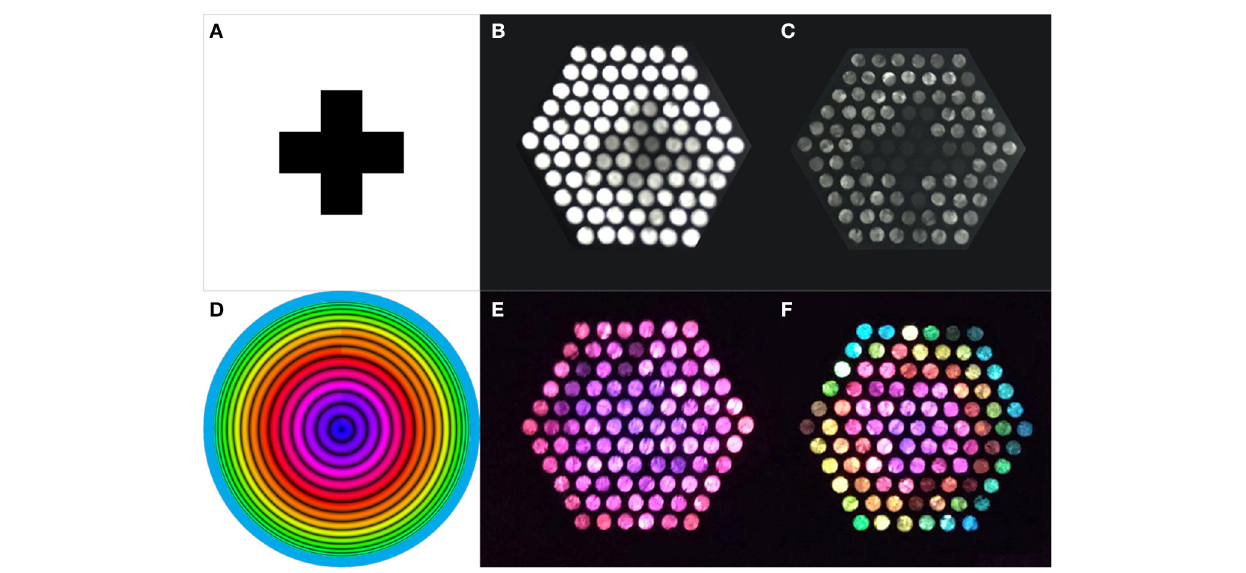
FIGURE 11 | Testing prototype 2 with two different pictures to illustrate changes in α and β separately. In the top row, (A) Shows the picture used at the object side, a black cross on white background placed about 10cm in front of the tubes. In this experiment α was changed while keeping β constant. Images (B,C) are photographs taken on the image side of prototype 2, with (B) large and (C) small α . The difference in light intensity and blurring is clearly visible. Image (B) has abundant light, but the cross can hardly be distinguished. In image (C) the cross can clearly be seen. In the bottom row, (D) Shows the picture of concentrically colored circles at the object side, placed about 30cm in front of the tubes. Now β was altered while keeping α constant. Images (E,F) are again photographs taken on the image side of the device. β is small in (E) , corresponding to only the inner circles of the provided picture, and large in (F) , where the outer bluish part of the picture can also be seen on the image side. This clearly illustrates the zooming